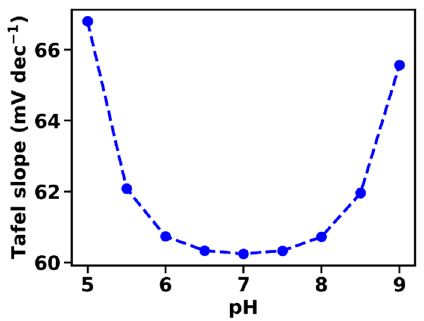
Figure 4. Tafel slopes at various pH extrapolated at 1 µ A cm − 2 , calculated according to the derivative of Equation (20). The pH dependence of the Tafel slope is closely related to the inverse of the buffer capacity of the electrolyte. The following parameters were used in the simulation: α ET = 1, k D = 10 mA cm mol − 1 , B 0 = 0.1 M, pK aB = 7.